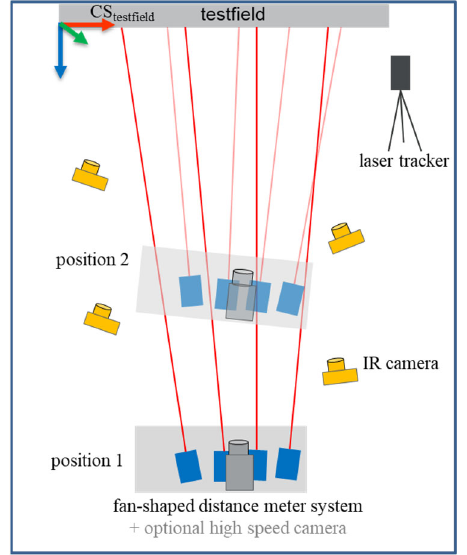
Figure 16. Concept of method 1 for determining the relative orientation